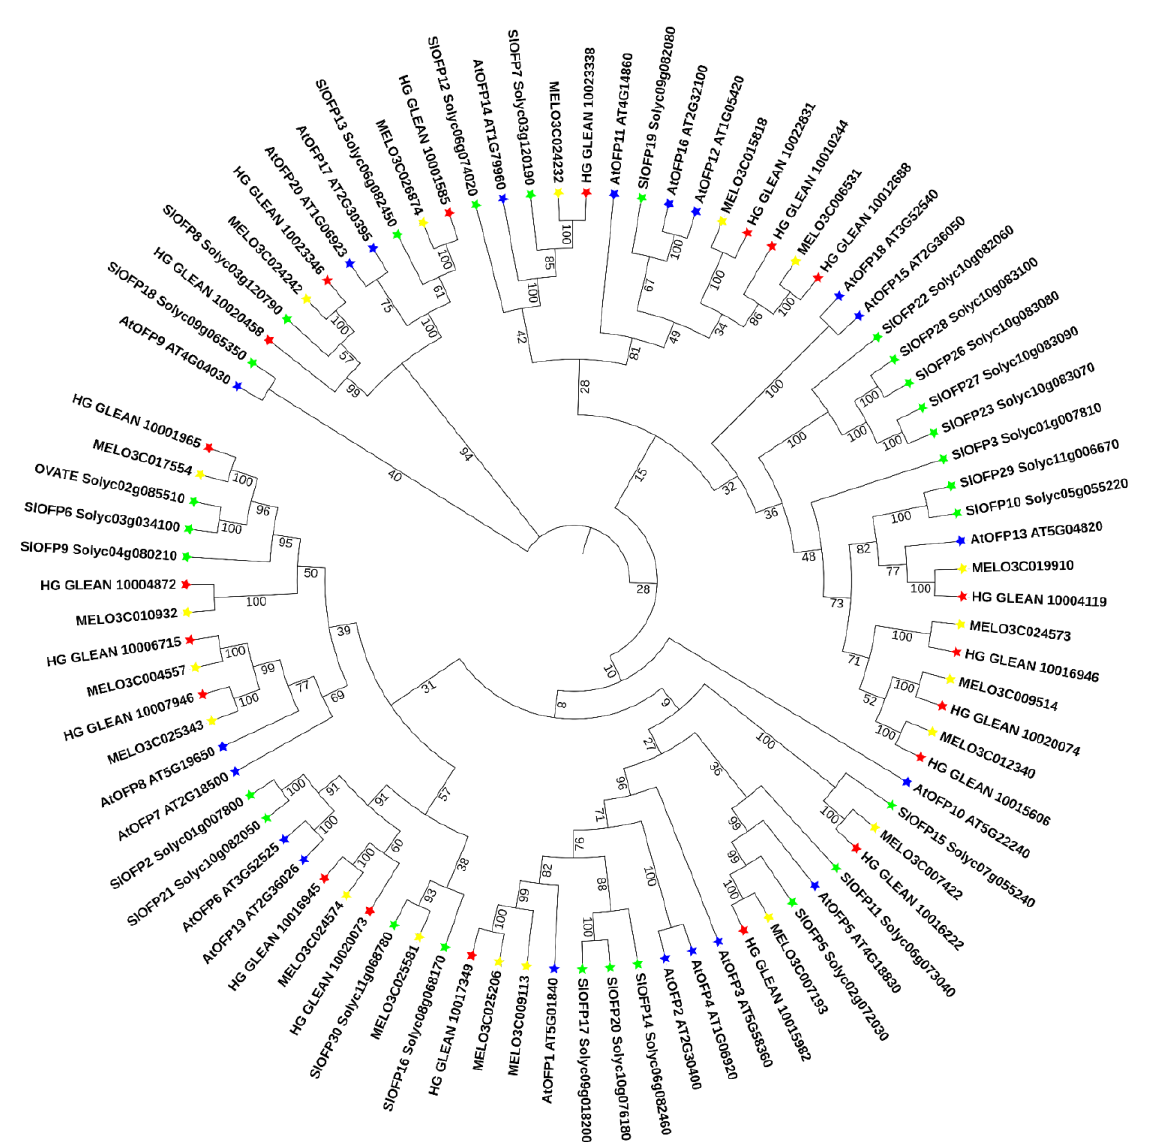
Figure 1. Phylogenetic relationships of the OVATE family in plants. The phylogenetic tree was con- structed using full-length amino acid sequences of the 86 OVATE gene families and MEGA 7.0. Green, yellow, red, and blue stars represent tomato, melon, bottle gourd and Arabidopsis genes, respectively.